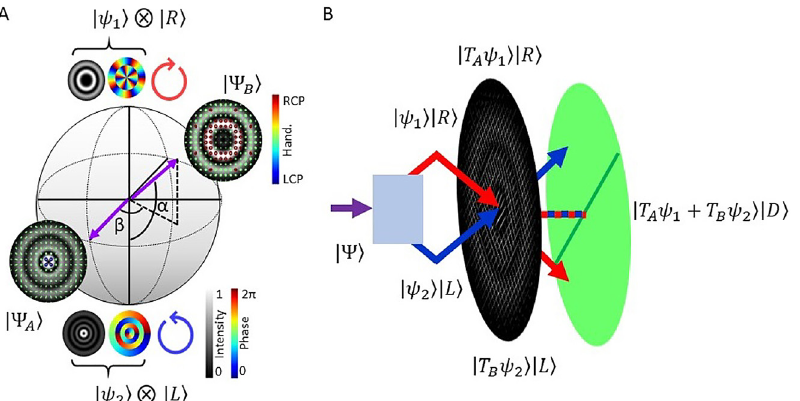
Figure 1: Concept diagrams illustrating our characterization scheme. ⟩ = LG 5( − 1) , the SOP of two example states on the sphere are included as insets – as well as the intensity and phase of the (A) HOPS with | 𝜓 1(2) 1(3) polar spatial modes and their associated circular polarization handedness. (B) Schematic showing the separation of orthogonally polarized components from a vector state | Ψ ⟩ , by a Wollaston prism, followed by a complex amplitude hologram and their projection into the same diagonal plane using a linear